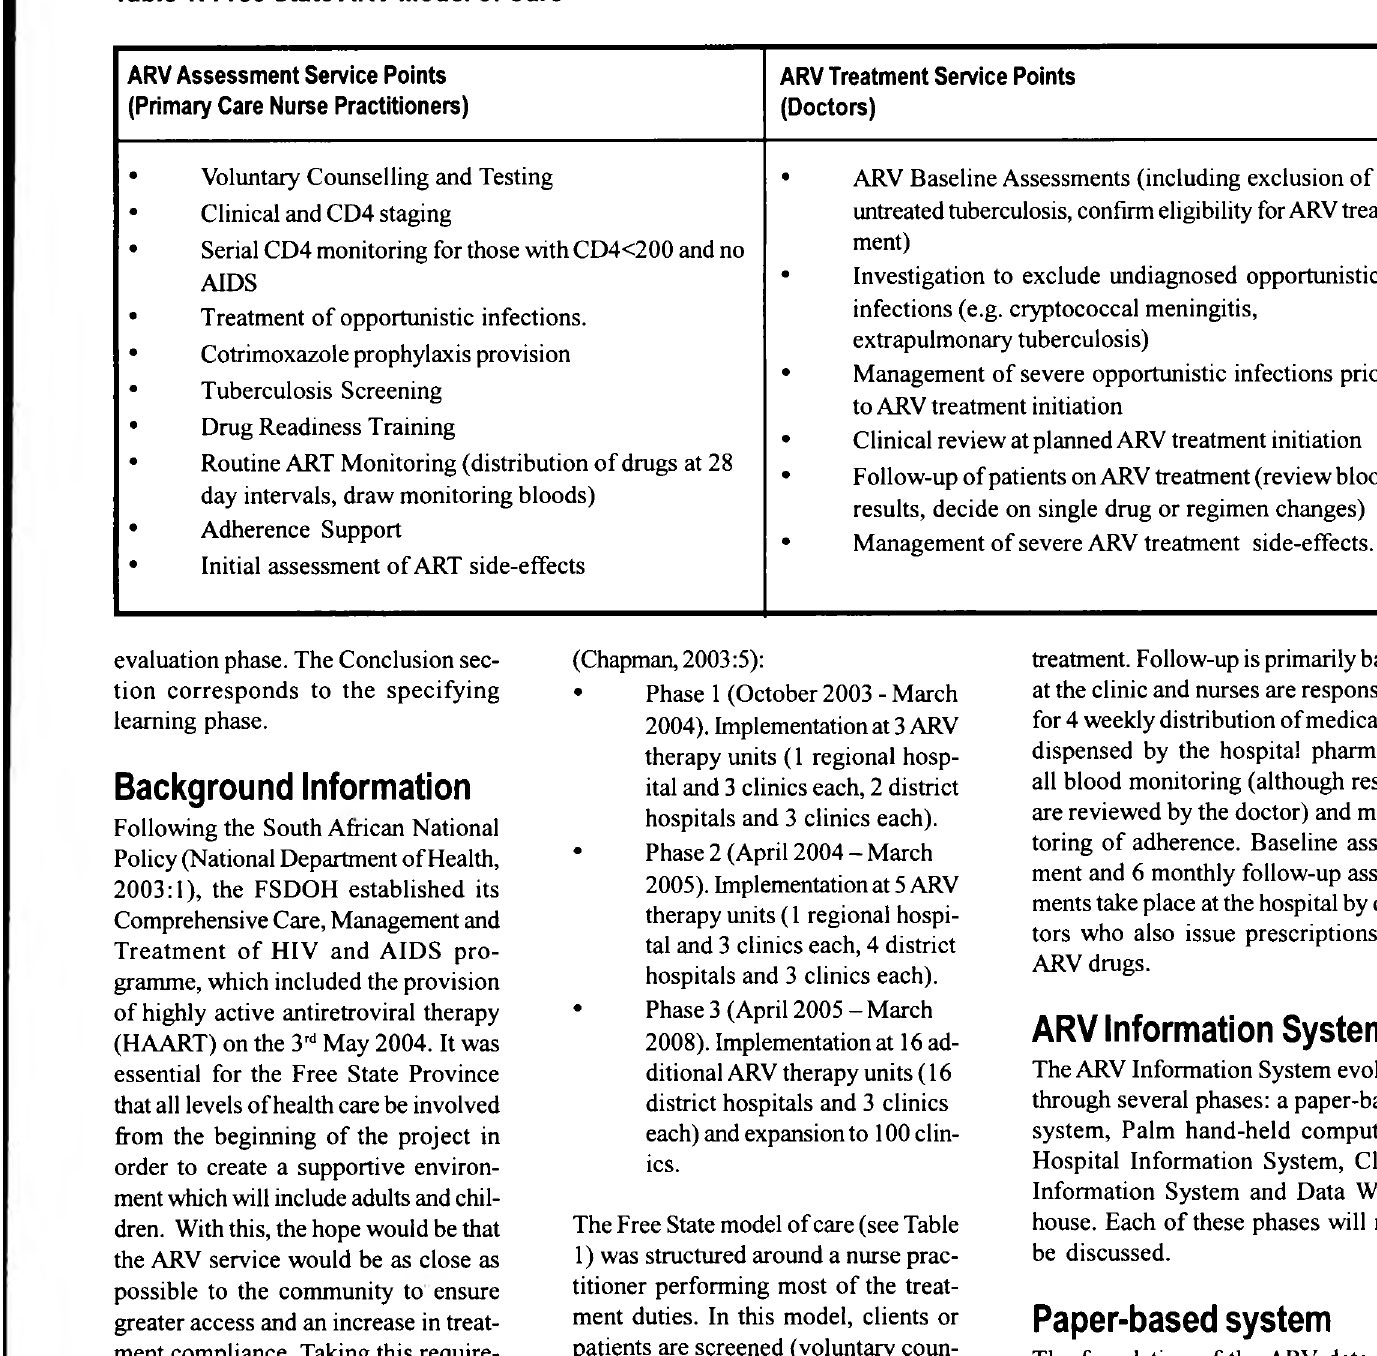
Table 1: Free State ARV Model of Care ARV Assessment Service